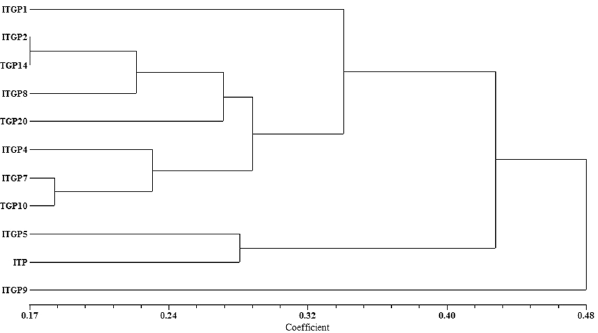
Figure 8. Dendrogram showing the genetic relationships between Improved Tapaswini (RP) and selected gene pyramids based on combined data of morphological and quality